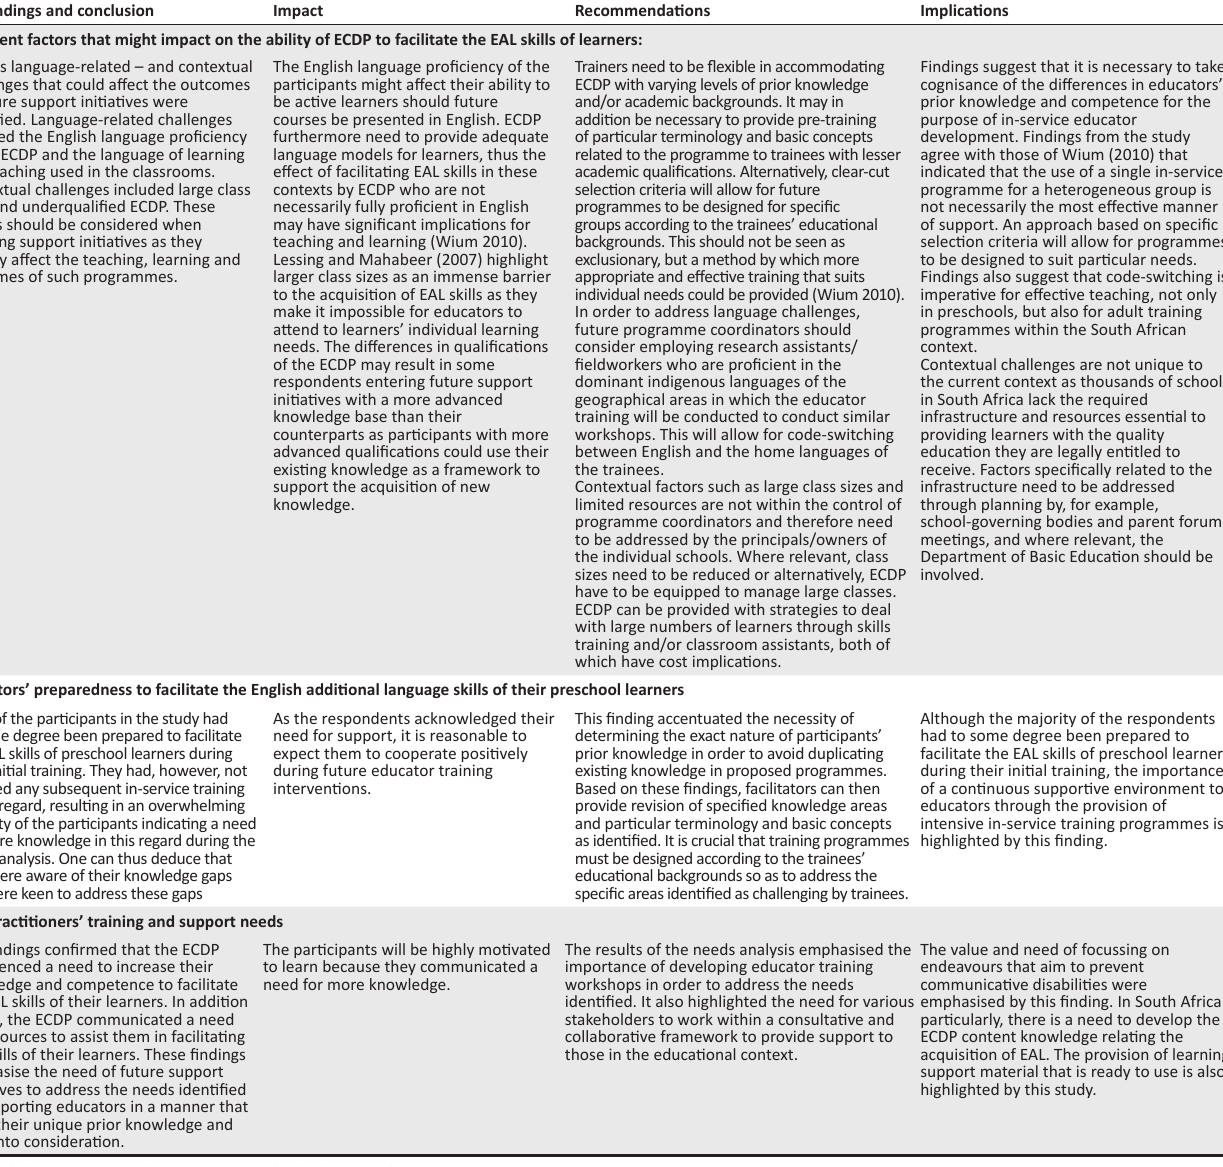
TABLE 4: Recommendations and implications to guide future support